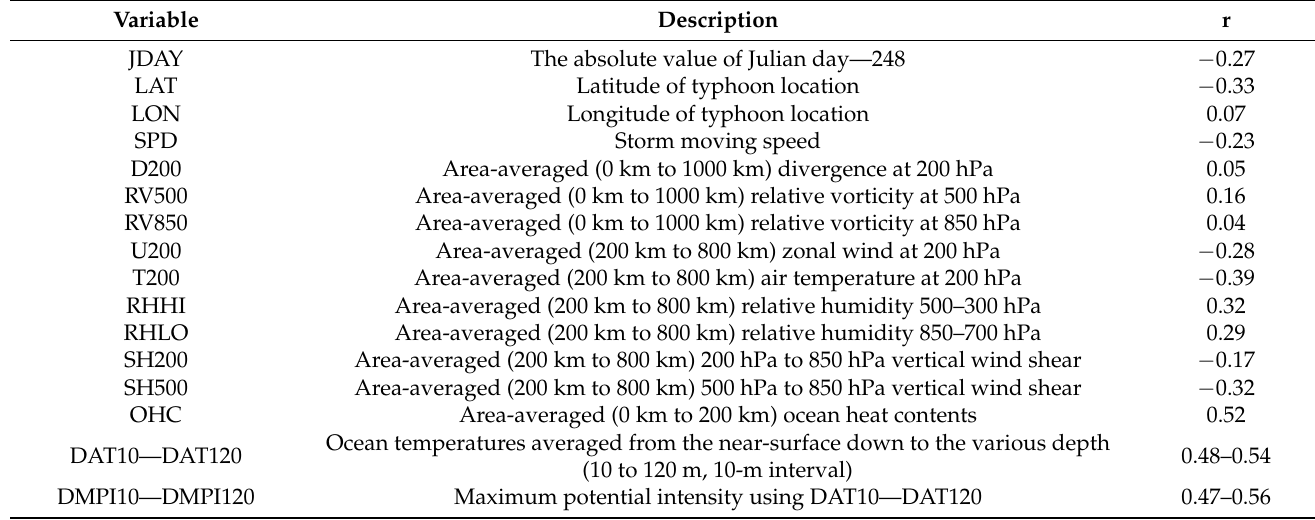
Table 1. Potential variables in the present model and their correlation coefficients (r) with the lifetime maximum intensity for the 2004–2013 TWNP TCs (Cluster 2 in CTIPS-DAT). All the variables were averaged along the TC track from the genesis to 3.25